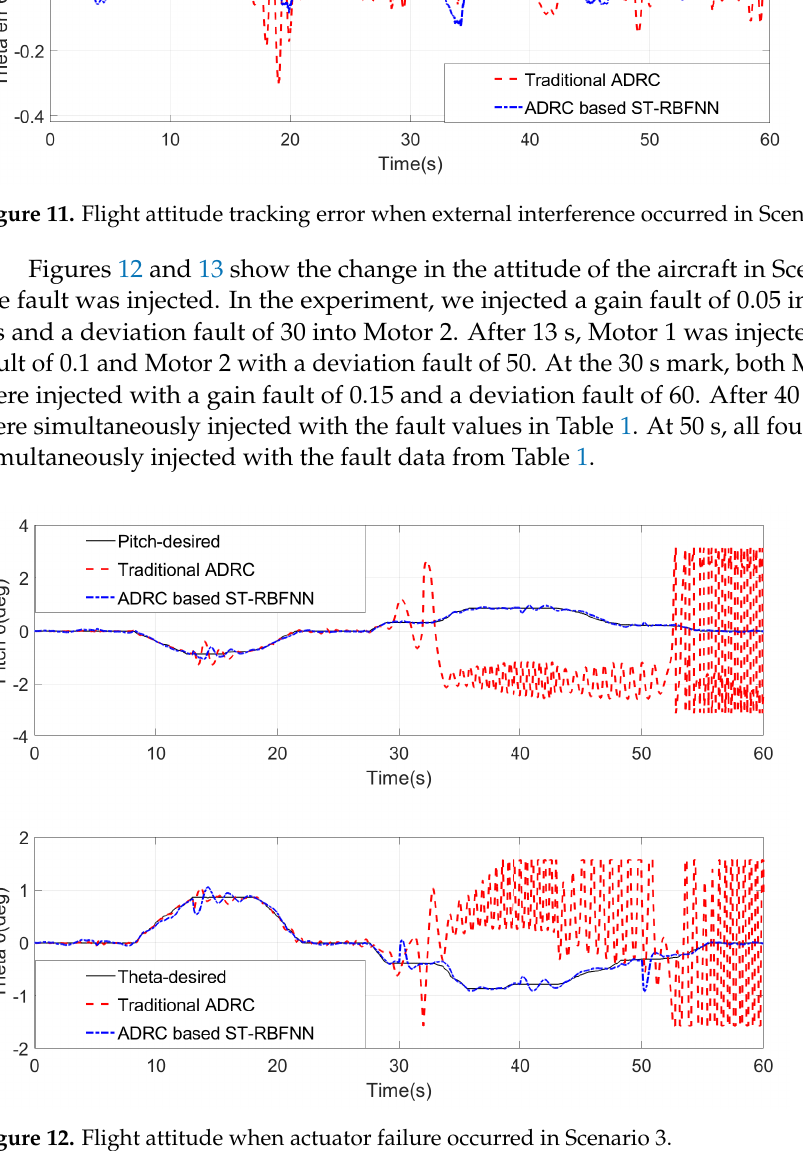
Figure 12. Flight attitude when actuator failure occurred in Scenario